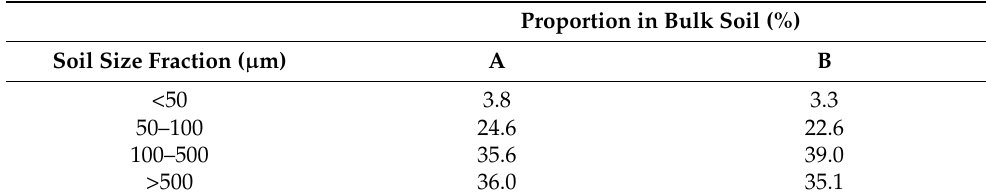
Table 1. Proportion (by mass) of each soil fraction in bulk soil collected from a functional bioretention cell in Drammen, Norway, close to the inlet (A) and 5 m away from it (B).